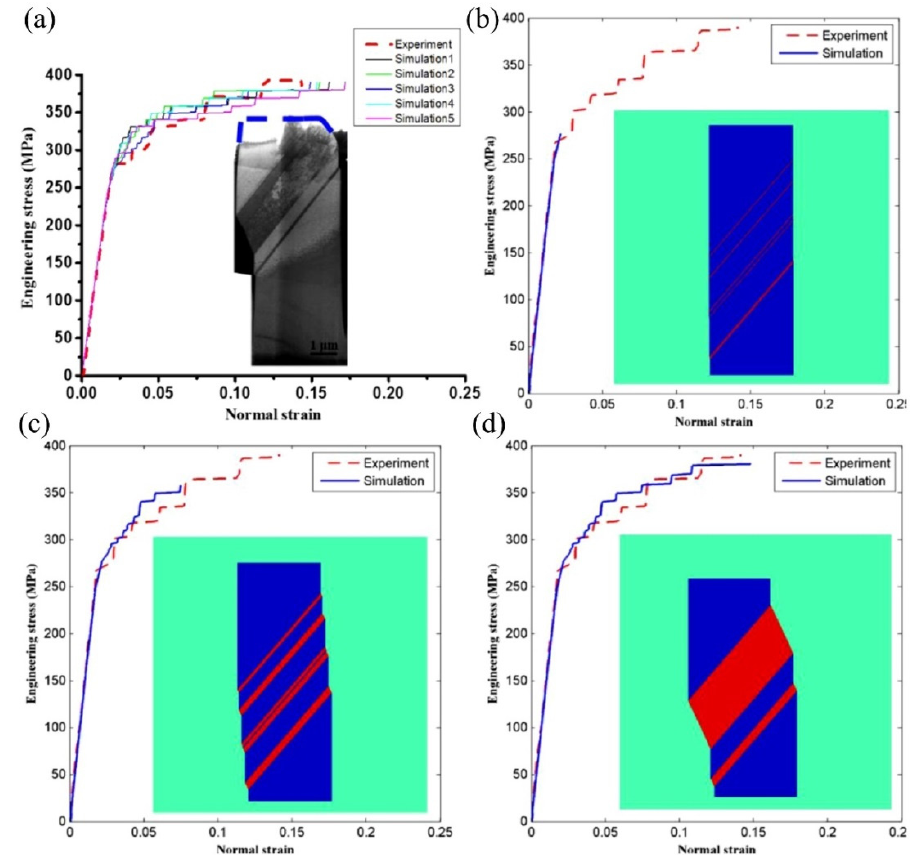
Figure 11. ( a ) The comparison between the simulated stress–strain curves and the one obtained by experiments. The inset shows the formation of twins in the austenitic pillar after the compression test. ( b – d ) The simulated stress–strain curve at different engineering strains together with the corresponding morphology of deformation twins [70]. The red color in ( b – d ) represents the deformation twins. Reprinted with permission from ref. [70]. Copyright 2015, Elsevier.